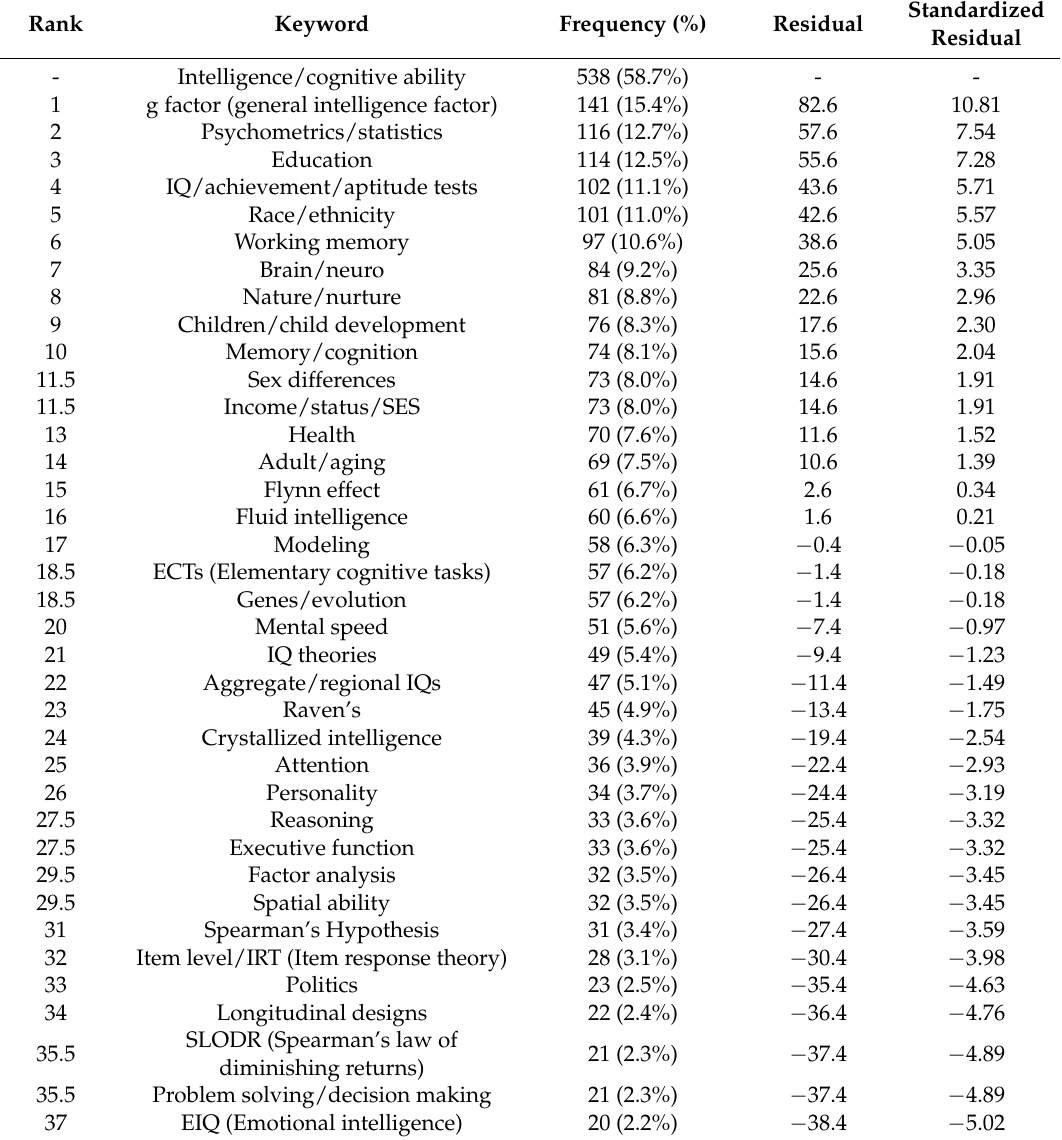
Table 1. Frequencies, percentages, and residuals for the 37 keywords with the most counts in the article